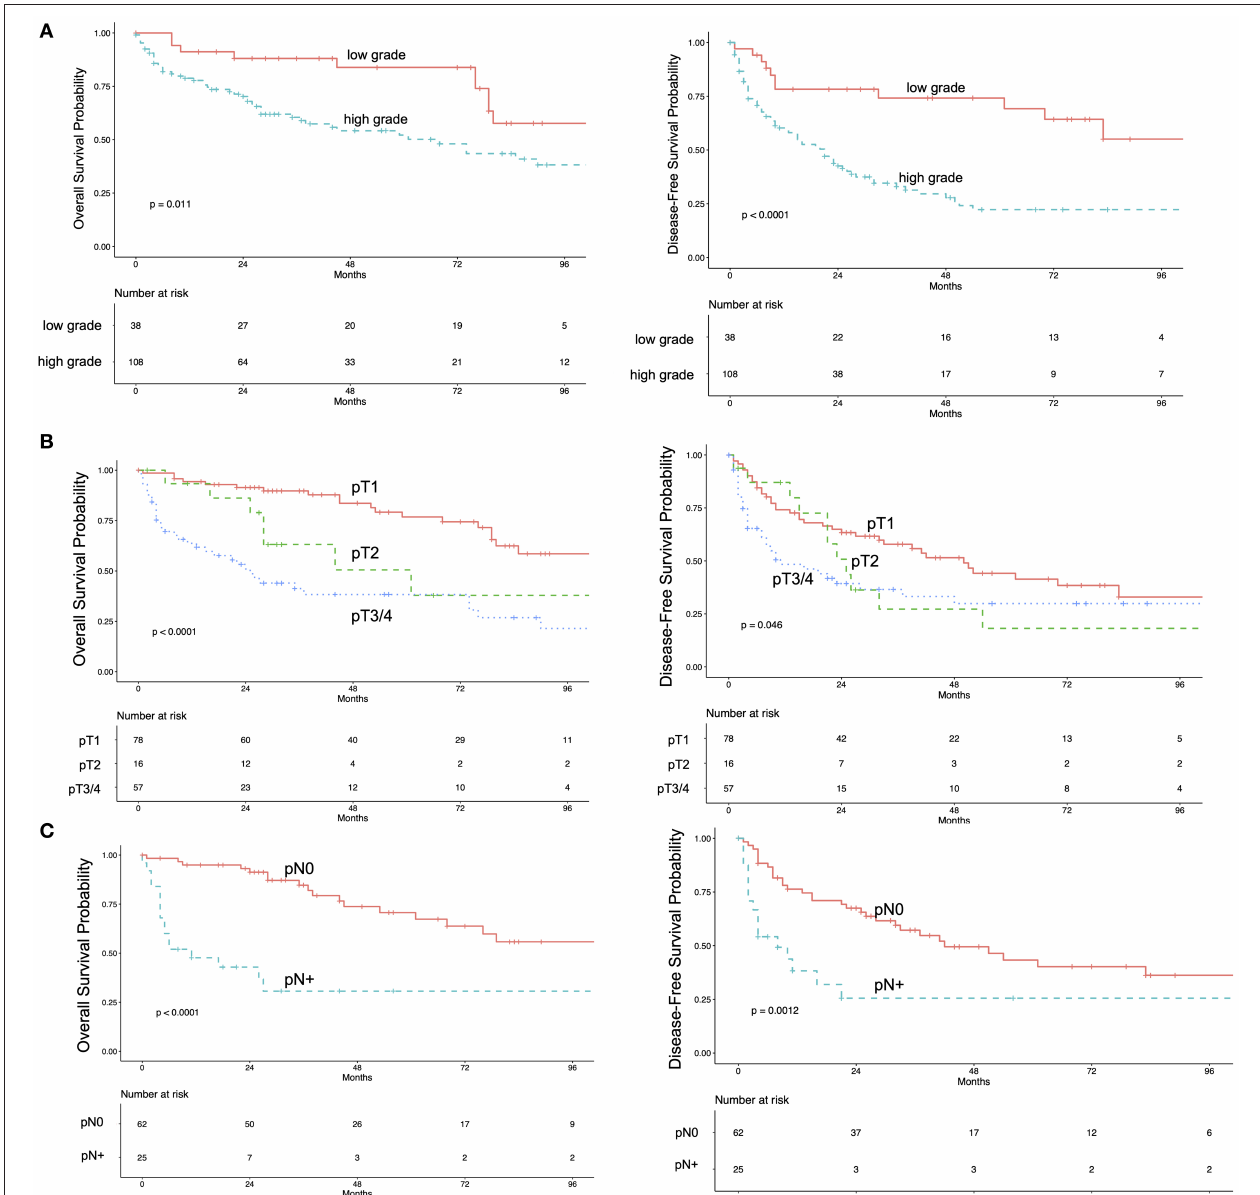
FIGURE 3 | Kaplan-Meier estimates for overall survival (left) and disease-free survival (right) in 151 patients with upper tract urothelial carcinoma stratified by pathologic grade (A) pathologic T-Stage (B) and lymph node status (C) .